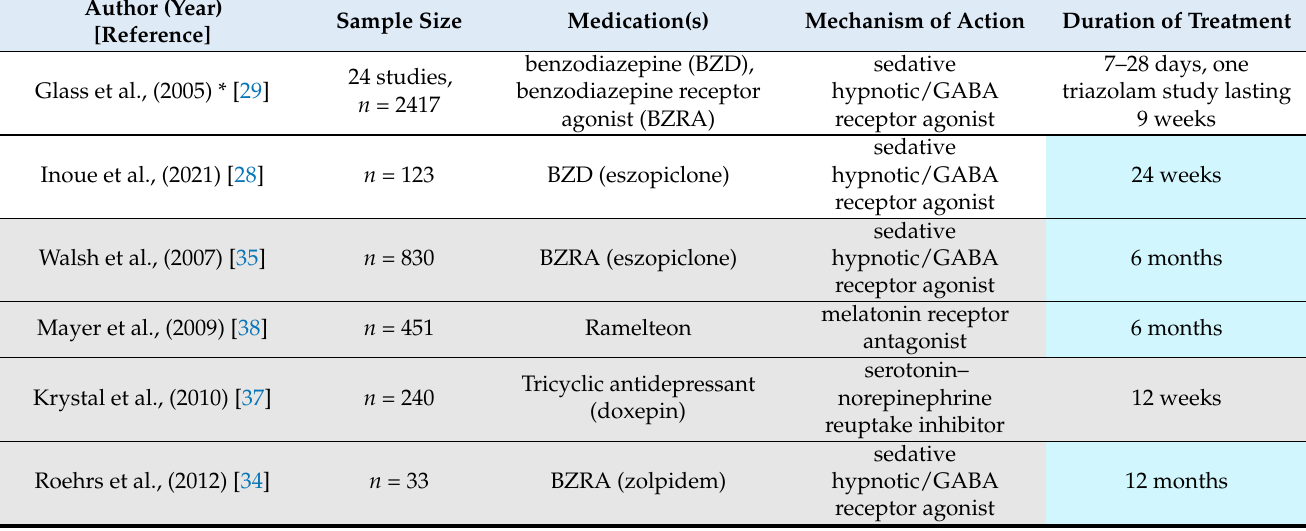
Table 1. Clinical study references presented to the expert panel for the review of relevant clinical evidence regarding the long-term use of insomnia medications. * Denotes meta-analysis. White background = evidence supporting the focus statement, light grey = evidence refuting the focus statement, pale blue = study was 24 weeks or